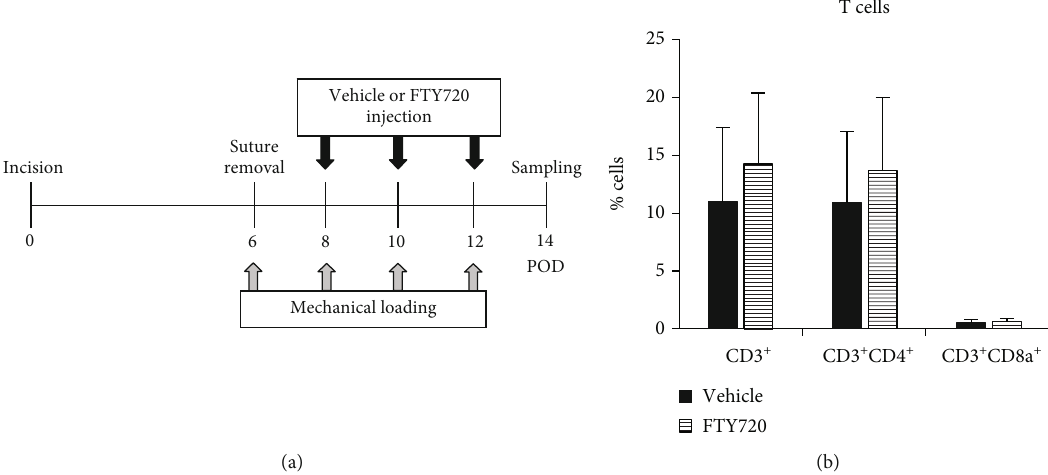
Figure 1: E ff ect of topical FTY720 injection on the Day 14 T cell population in the scars. (a) Schematic depiction of the schedule in which mechanical force-induced hypertrophic scars were generated in mice and treated with FTY720 injections. (b) The frequencies of CD3 + , CD3 + CD4 + , and CD3 + CD8a + T cells in the scars were determined by fl ow cytometry ( n = 7 ). Two independent experiments were performed. Both showed similar results. All values shown represent means ± s : e : m